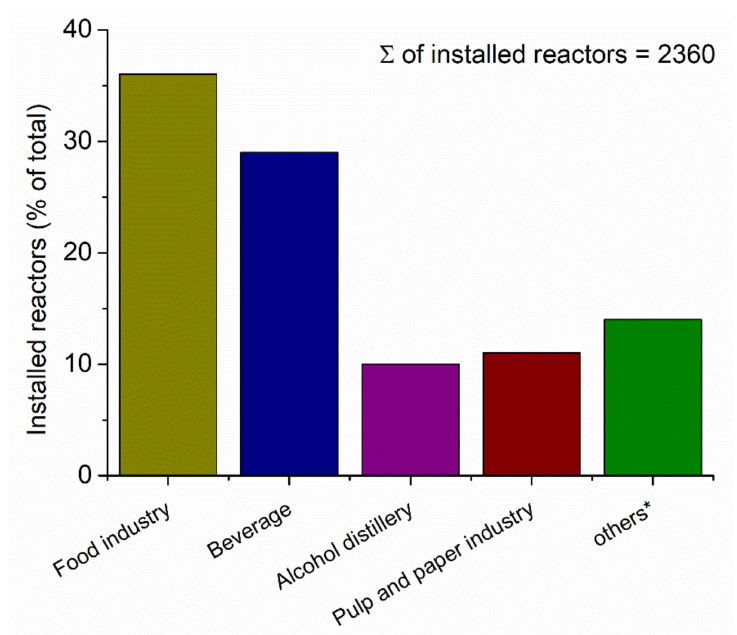
Figure 4. Application of anaerobic technology to industrial wastewater. Total number of registered installed reactors = 2360; * chemical, pharmaceutical, sludge liquor, landfill leachate, acid mine water, municipal sewage; adopted from [53] and updated and edited by the authors.